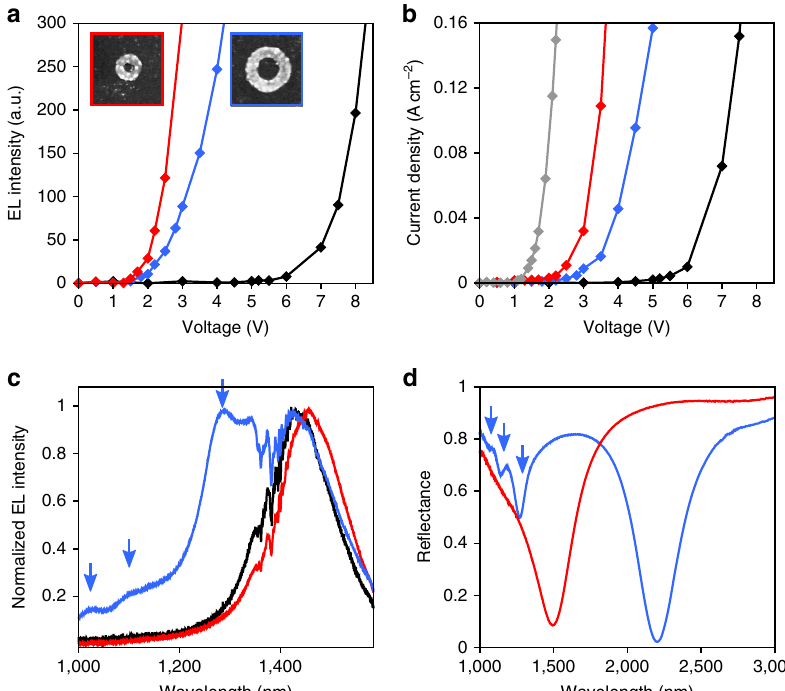
Figure 3 | Properties of the metamaterial LEDs. ( a ) L – V curves for the reference QLED (black), the metamaterial LED with small rings of Fig. 2 (red curve) and the metamaterial LED of Fig. 1 with large rings and period (blue curve). This colour code is used in the other panels of the figure. ( b ) J – V curves for the same devices. Also shown is the J – V curve of a QLED where the nanoparticle array has been replaced by a continuous gold film with the same thickness (in grey). ( c ) EL spectrum of the three devices, with the plasmonic resonances of the blue curve highlighted with arrows. The noise in the 1,345–1,480nm window is due to the absorption lines of the atmosphere. The small peak at 1,345nm, best seen on the blue curve, is also an artefact caused by these absorption lines. ( d ) FTIR reflectance spectra of the metamaterial LEDs. All these properties are stable even after numerous electrical pumping